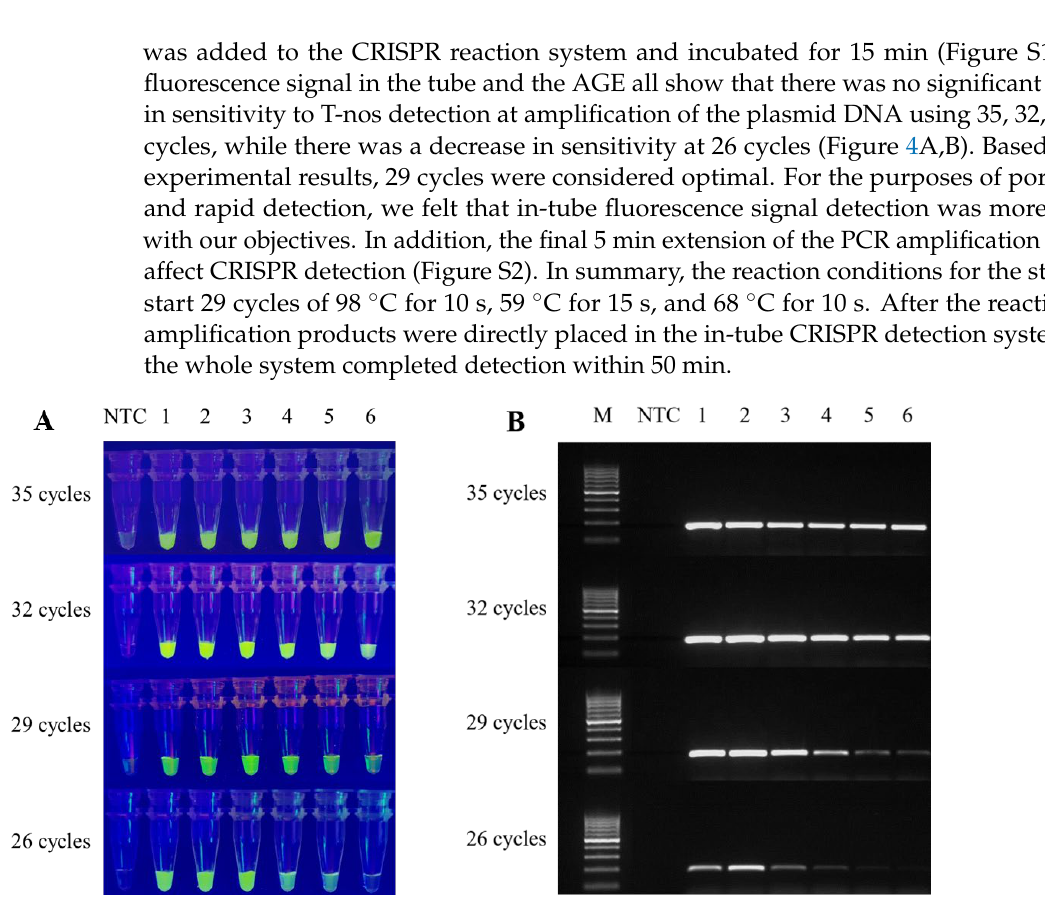
Figure 4. Detection of conventional PCR amplification products by the CRISPR/Cas12a system, and visualisation by AGE. The template was 5-fold serially diluted. ( A ) CRISPR bulk assay. ( B ) AGE visualisation. M, DNA Ladder H1 (100~1000 bp); NTC, no template control; Lanes 1 − 6, 9 × 10 4 , 1.8 × 10 4 , 3.6 × 10 3 , 7.2 × 10 2 , 144, and 29 copies/μL plasmid.